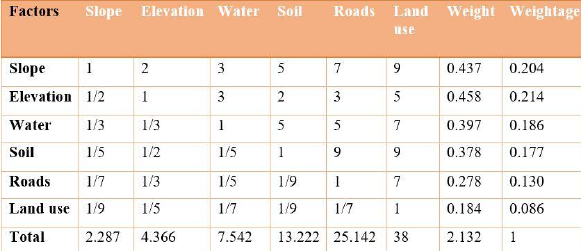
Table 2 : The pairwise comparison matrix